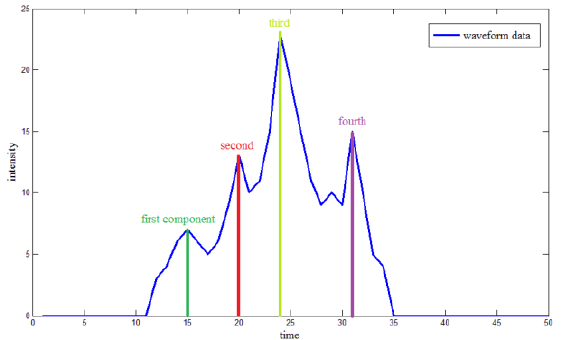
Figure 2. Simulated backscatter return waveform which